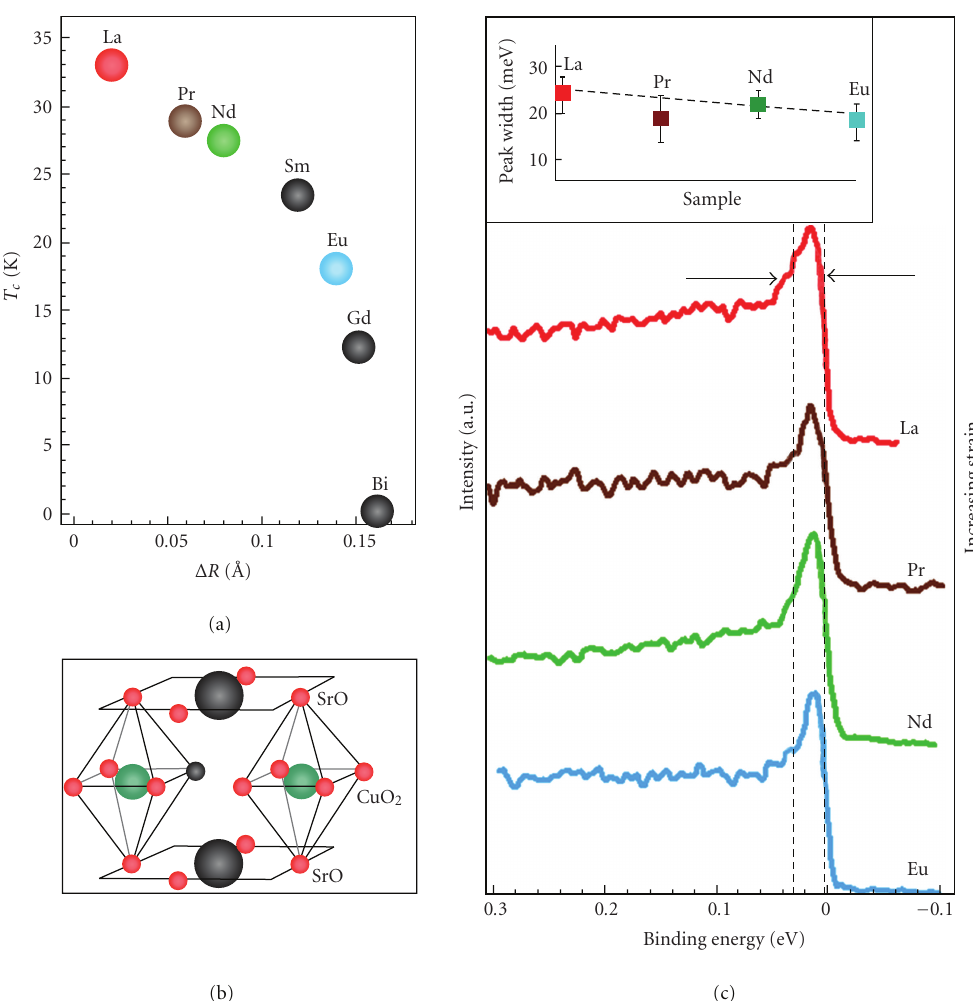
Figure 19: (a) Superconducting T c for optimally doped Bi 2 Sr 1 . 6 Ln 0 . 4 Cu 2 O 6 for a series of substituted Lanthanides (Ln) with increasing atomic radius mismatch, Δ R = | R Sr − R Ln | . See [68]. (b) Cartoon illustrating the location of the substituted Lanthanide right above the Cu-O plane. (c) Nodal point EDCs illustrating the quasiparticle peak for samples with increasing strain, colored in (a), from La to Eu. Inset quantifies the half-width half-max of the peaks for these